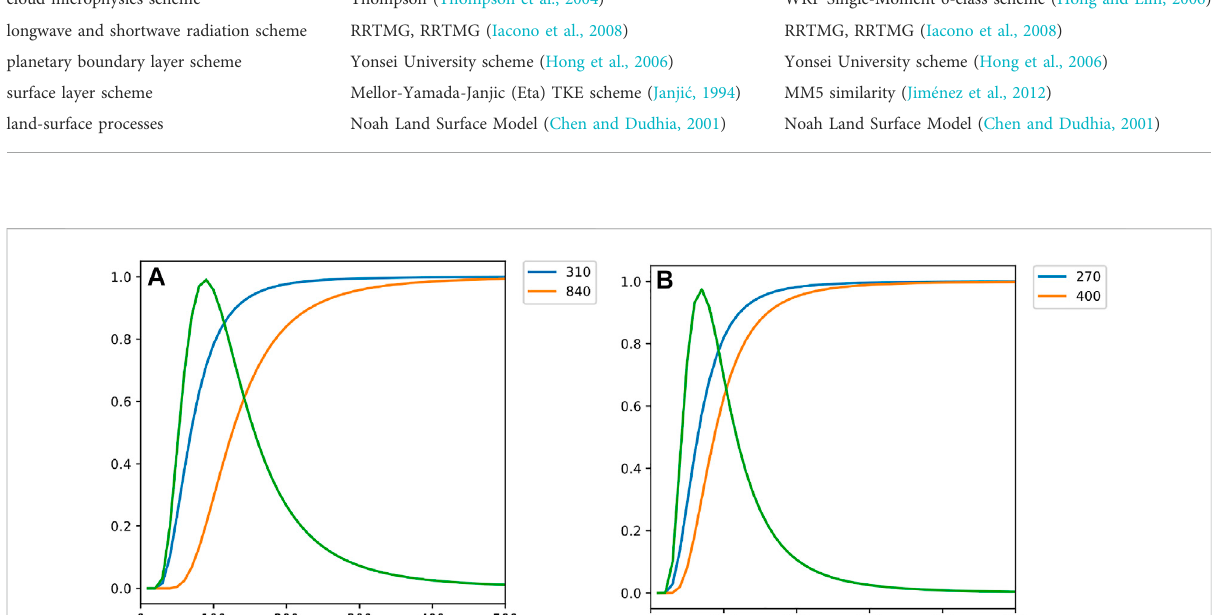
FIGURE 2 The band-pass fi lter response functions of (A) rainfall in 2021 and (B) snowstorm in 2018. The orange line and blue line are for the low-pass fi lters used to de fi ne te bandpass fi lter represented by the green line, the numbers in the upper right corner of the fi gure represent fi lter